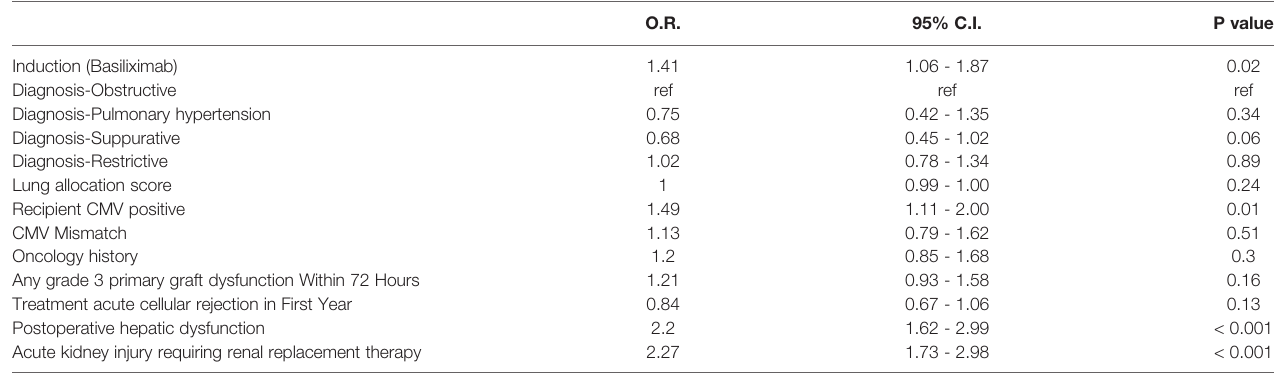
TABLE 3 | Multivariable Cox regression predicting post-transplant survival.